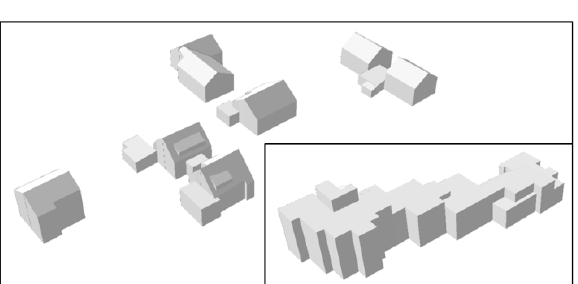
Figure 10. 3D visualization of rooftop models produced by sequential modelling